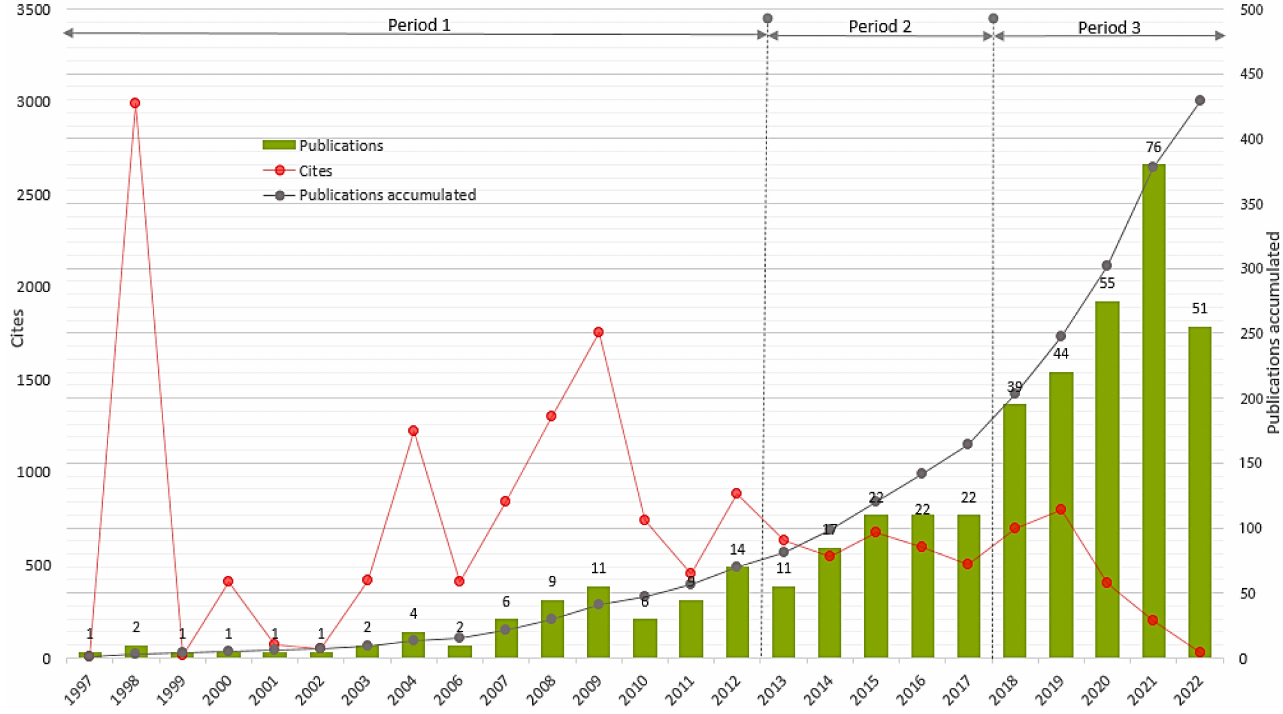
Figure 3. Distribution of publications and citations by year